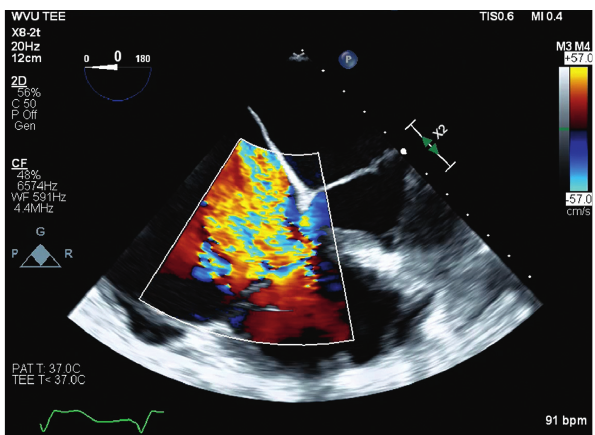
Figure 1: Transesophageal echocardiography, midesophageal four- chamber view demonstrating severe tricuspid regurgitation in patient with a leadless